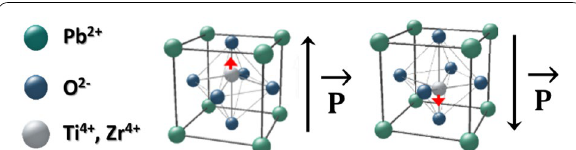
3 (PZT). The atomic structure of ferroelectric material (herein, PZT) is shown. The polarization direction is set by externally applied